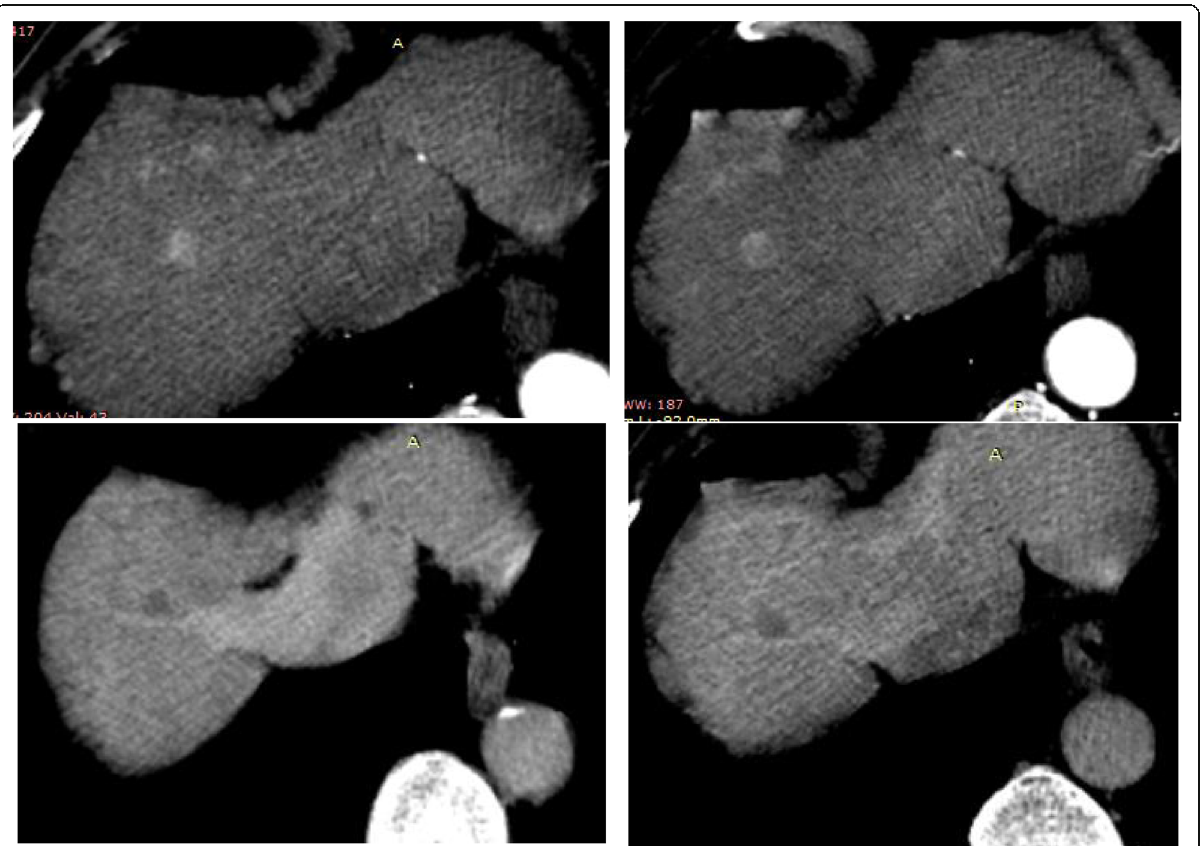
Fig. 8 Case 5: a 65-years-old male patient with cirrhosis. a MDCT in the arterial phase dated October 2016 reveals a small segment V right lobe hyper-enhancing nodule measuring 12 mm showing washout in the delayed phase ( b ); this lesion is categorized as LIRADS 4 by LI-RADS version 17 and LI-RADS 5 by LI-RADS version 18. c , d MDCT in the arterial and delayed phases for the same patient 5months later showing size progression of the lesion measuring 17mm still with similar enhancement dynamics and similar staging by both LIRADS systems